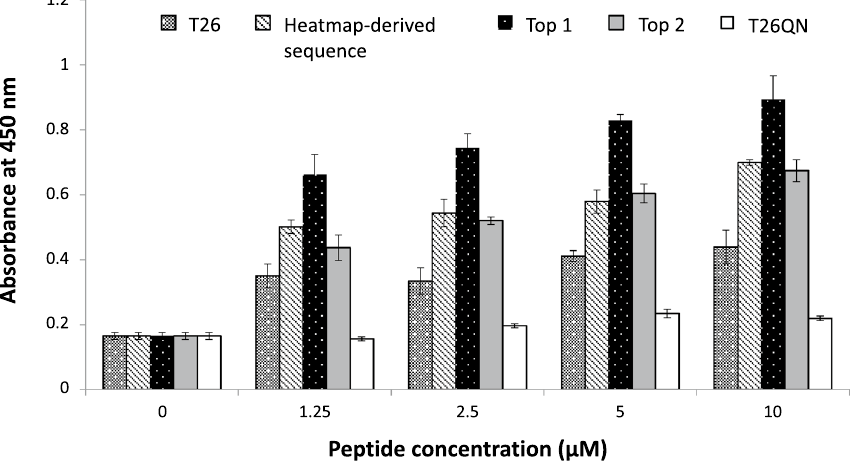
Figure 3. Reactivity of the top enriched peptides, Top 1 and Top 2, and heatmap-derived sequence (Q-Q- C-Y-I-) in comparison to T26 and non-substrate peptide, T26QN, determined by the TG2 enzymatic assay. Assay was carried out in plate format using biotinylated peptides in the concentration range 0–10 μM with immobilized casein as amino donor, as described in Methods. Reaction products were detected by absorbance at 450 nm. Bars represent means of triplicate measurements with STD indicated for each measurement. All peptides were chemically synthesized with N-terminal biotin tag by Bio-Synthesis, USA and provided by Biologica,